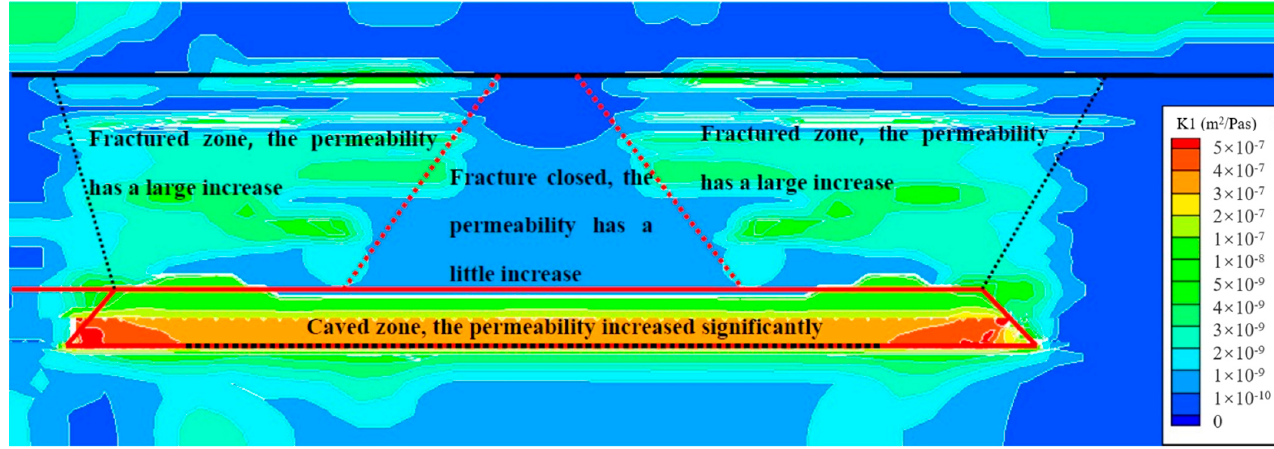
Figure 6. The contour plotting of permeability distribution on longitudinal cut plane of model.